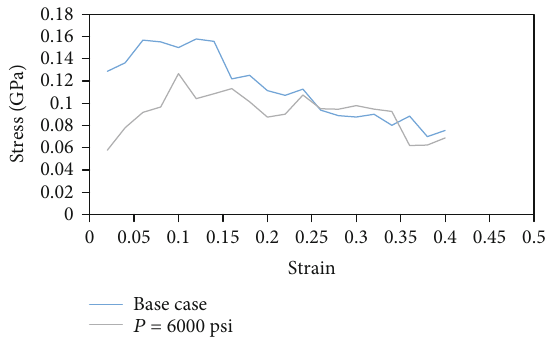
Figure 15: Tensile mechanical deformation of 19.68% porosity kerogen structure for empty and fi lled with methane cases at